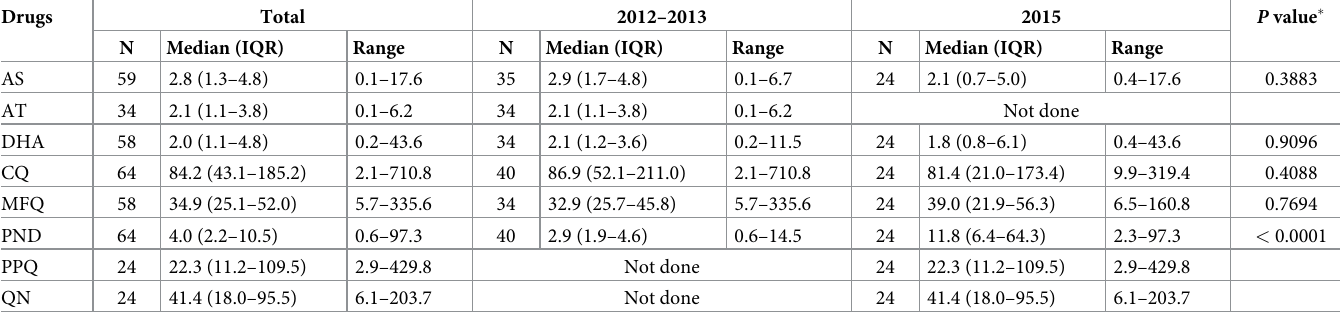
Table 1. Ex vivo IC 50 values (nM) of clinical P . vivax isolates to eight antimalarial drugs.